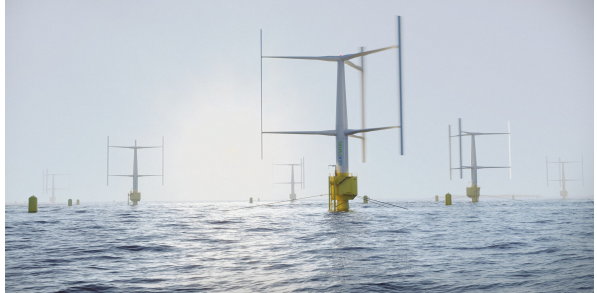
Figure 1. Offshore floating vertical axis offshore wind turbine